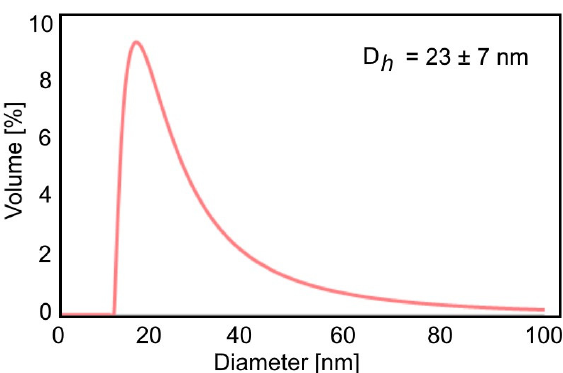
Figure 1. TEM micrographs of CdSe QDs displaying la tt ice fringes and di ff raction pa tt ern. ( a ) TEM overview of cluster CdSe QDs coated with PVP. ( b ) HR-TEM (inset) showing la tt ice fringes of or- dered CdSe QDs. ( c ) Di ff raction pa tt ern showing crystal structure of CdSe QDs to third order, which is typical of CdSe crystals.